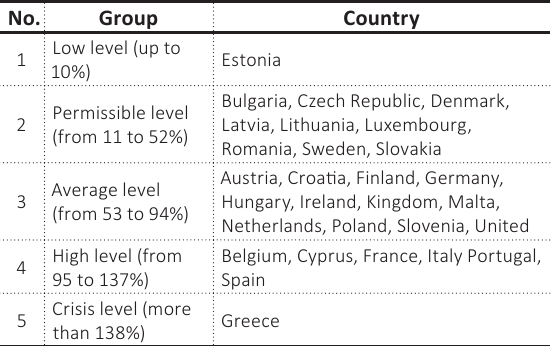
Table 3. General government gross debt to GDP ratio in European countries in